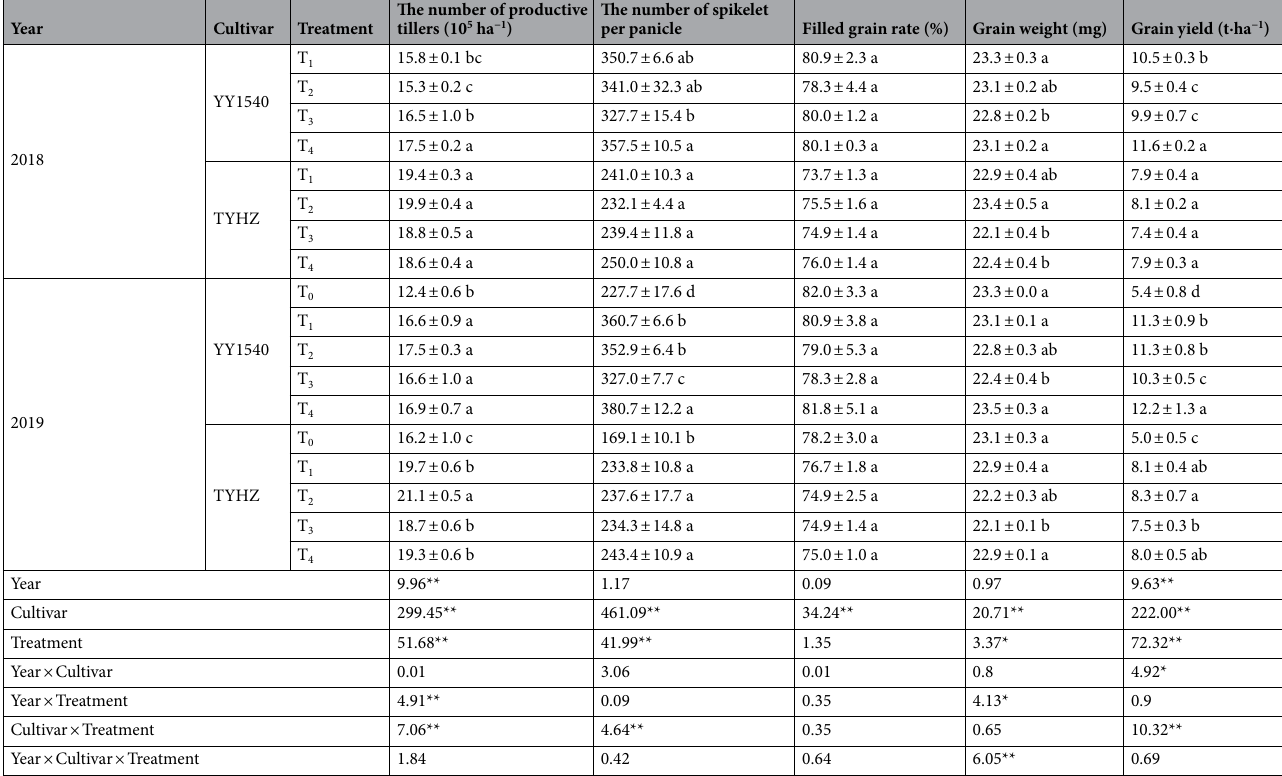
Table 1. Effect of nitrogen fertilization mode on grain yield and yield components of indica–japonica hybrid rice (‘Yongyou1540’, YY1540) and indica hybrid rice (‘Tianyouhuazhan’, TYHZ). Values followed by different lower-case letters within the same column are significantly different among treatments. * p < 0.05; ** p <